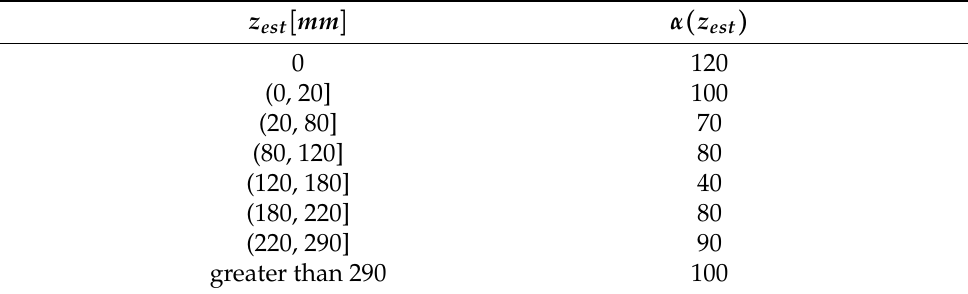
Table 2. Value of α that depends on the range of z est .